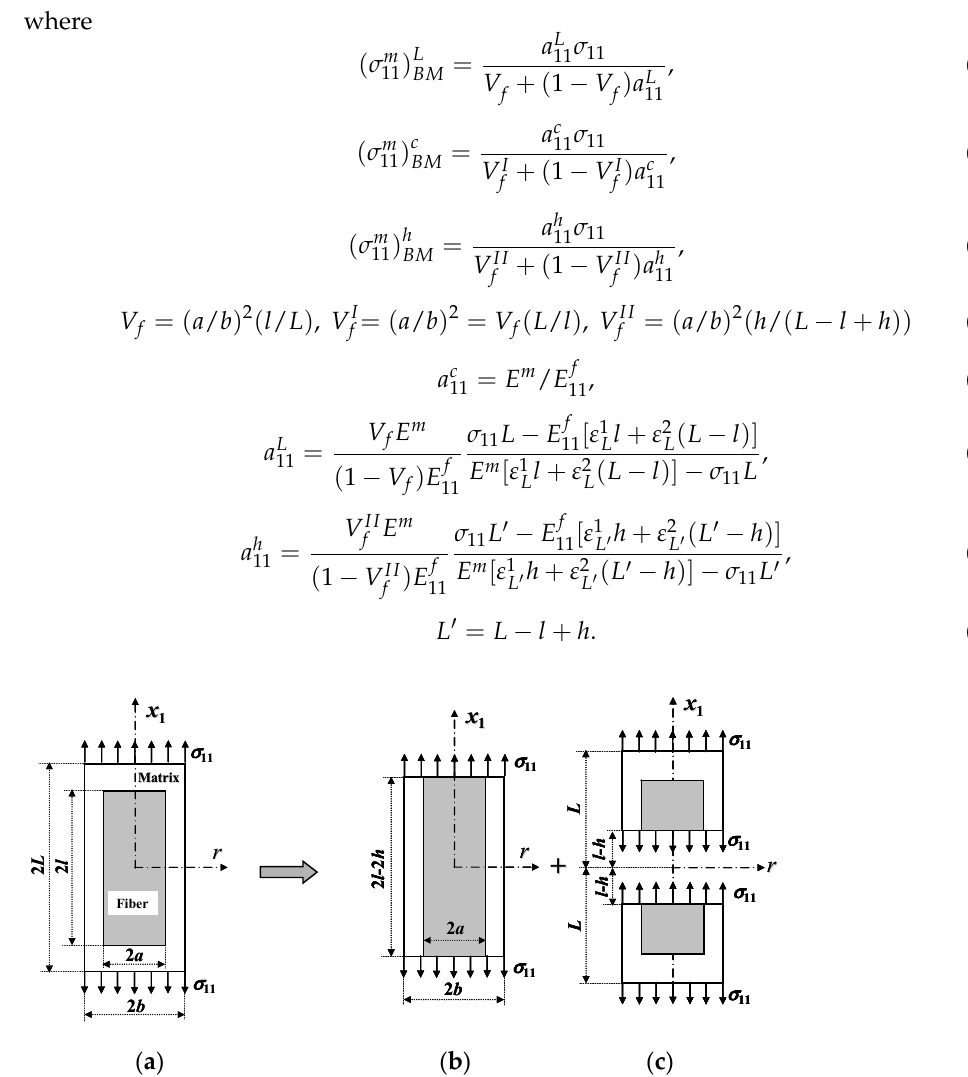
Figure 5. RVE of a short fiber composite ( a ) is separated into the RVE of a continuous fiber composite ( b ) plus two end segments of a short fiber composite with a small fiber aspect ratio ( c ). It is noted that Equation (61) is obtained from the second part of Equation (12), i.e., Equation (60), with L and l in Figure 3b and in Equations (16) replaced by L ’ and h , respectively, in which L ’ is given by Equation (62). The longitudinal tensile and compressive SCFs of the matrix in the short fiber composite are expressed